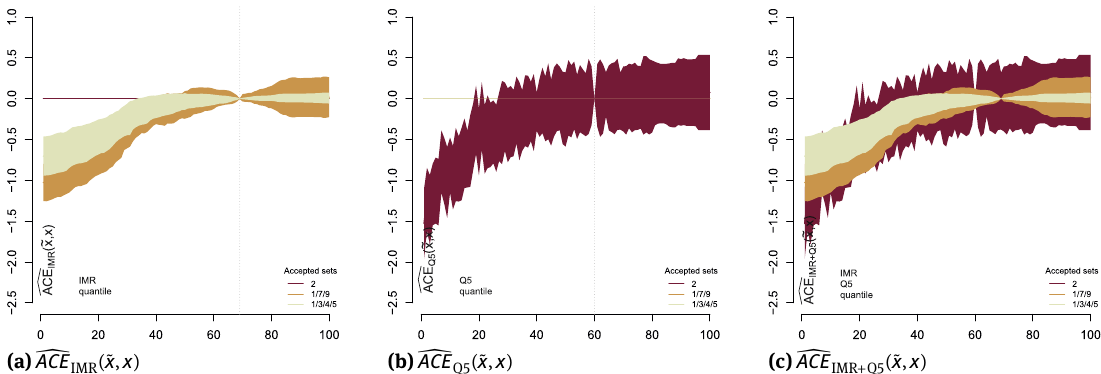
̂ F ̂ F , bounds the average causal effect of Figure 2: Data for Nigeria in 1993: The union of the confidence bands S , denoted by ̂ varying the variables in the defining set D 1 = { IMR, Q5 } on the target log ( TFR ) . IMR and Q5 have been varied individually, see panels (a) and (b), as well as jointly, see panel (c), over their respective quantiles. In panels (a) and (b), we do not observe con- sistent effects different from zero as some of the accepted models do not contain IMR and some do not contain Q5. However, ̂ when varying the variables D 1 = { IMR, Q5 } jointly (see panel (c)), we see that all accepted models predict an increase in ex- pected log ( TFR ) as IMR and Q5